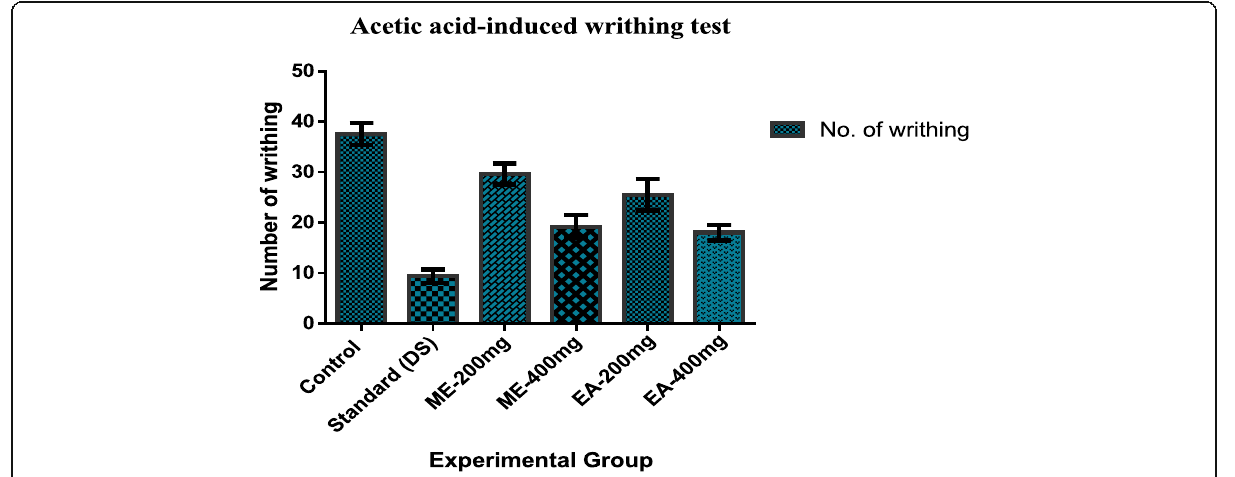
Fig. 4 Effect of Hemigraphis alternata methanolic and ethyl acetate extract treatment on acetic acid-induced writhing in mice. Each bar represents the mean ± standard error of the mean of writhing of five animals